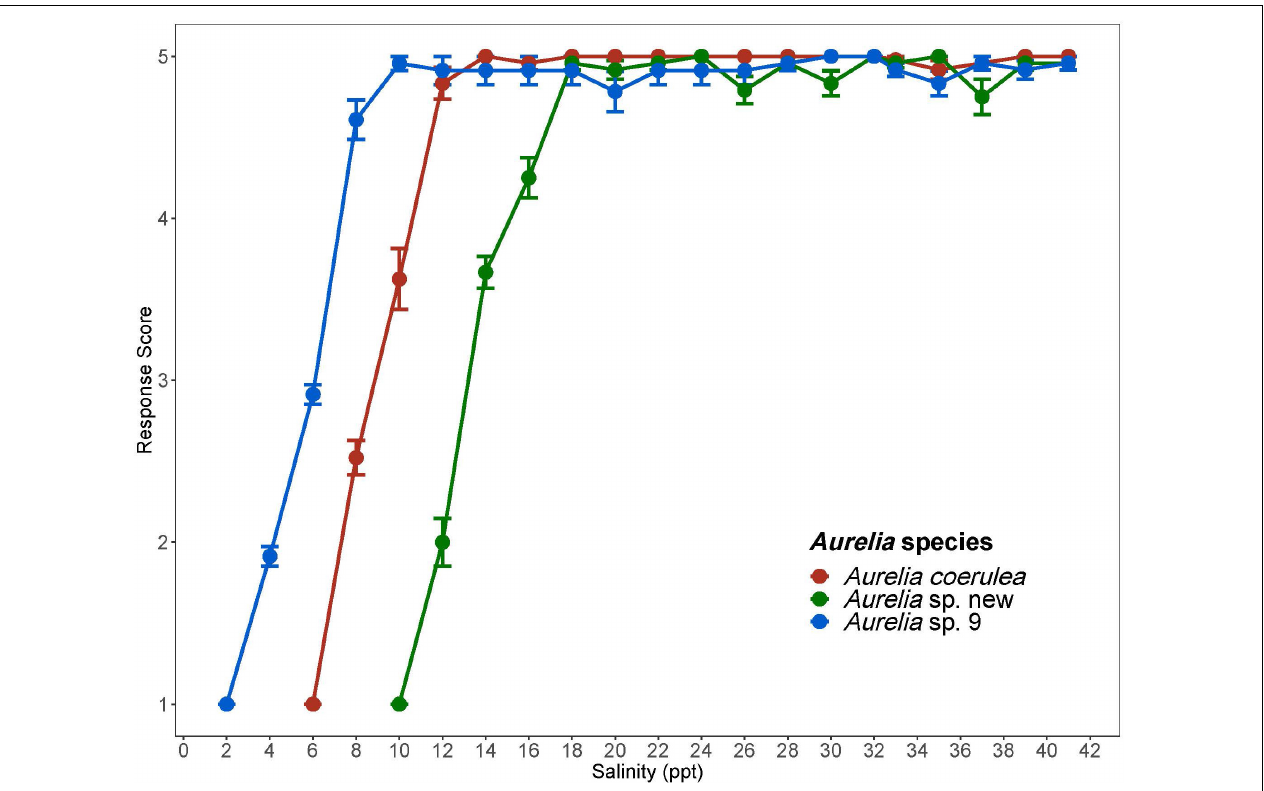
FIGURE 3 | Response scores of Aurelia species in response to 1 ppt/day salinity change. Response scores 1-5 are described in Table 1 . Salinity is in parts per thousand (ppt). Error bars display standard error. Colors correspond to Aurelia species: red is Aurelia coerulea , green is A. sp. new, and blue is A. sp.